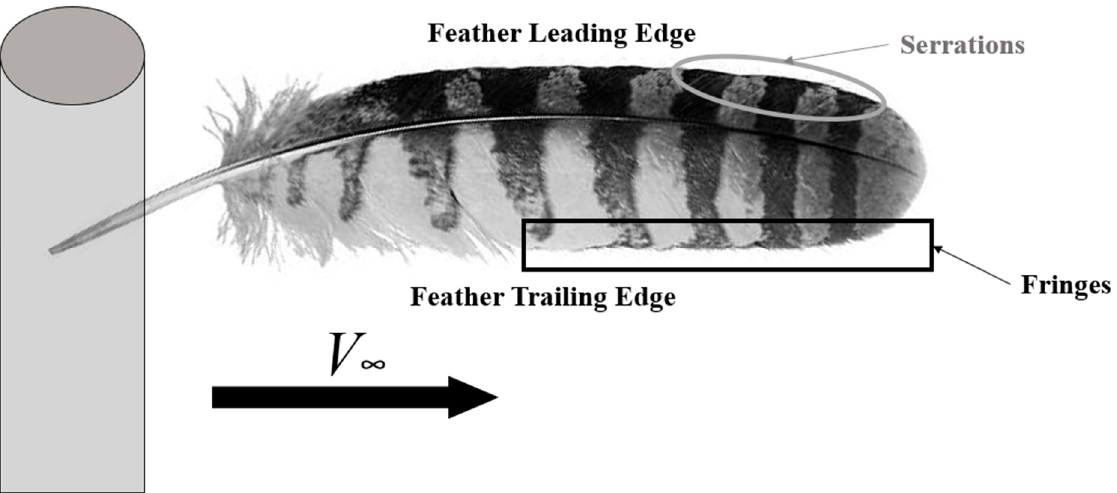
Figure 1. Representation of an owl feather and placements of serrations and fringes (the schematic is not to scale).